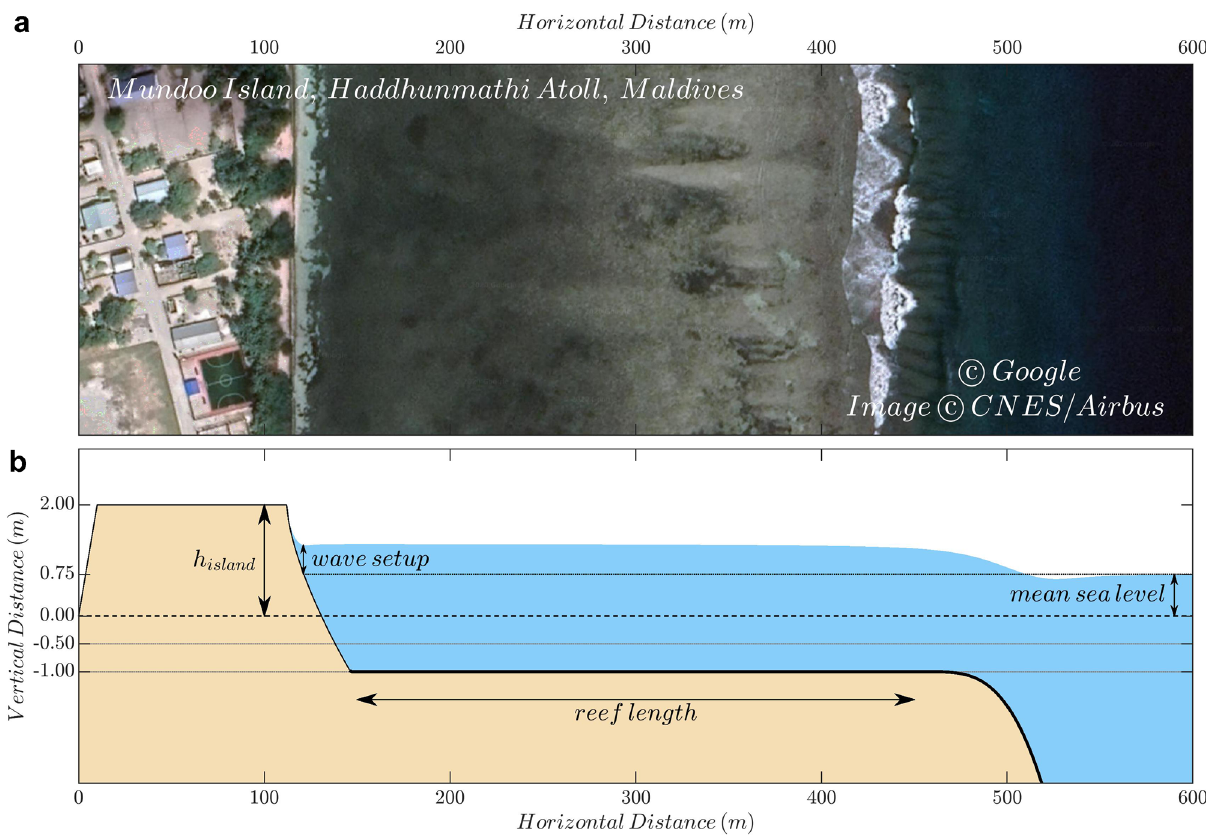
◦ ◦ E, 2.012024 N), located at Haddhunmathi